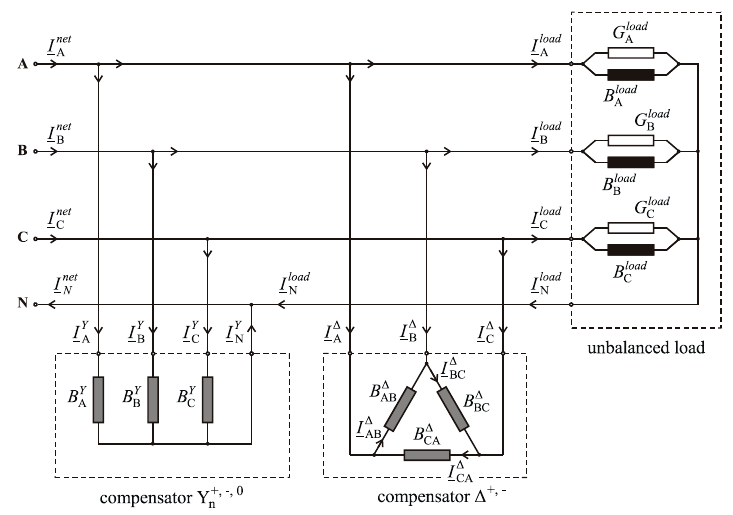
Figure 1. The BRC, in a three-phase four-wire network.